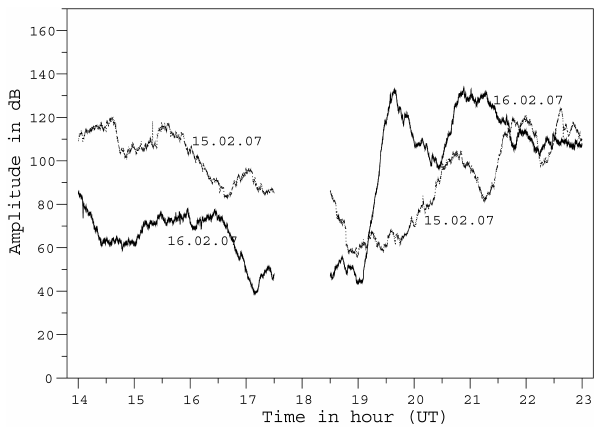
Fig. 2. An example of a quiet night time (15 February 2007) data as compared with an anomalously fluctuating night time (16 Febru- ary 2007) data. High fluctuations in the signal amplitude on the 16 February 2007 is evident.